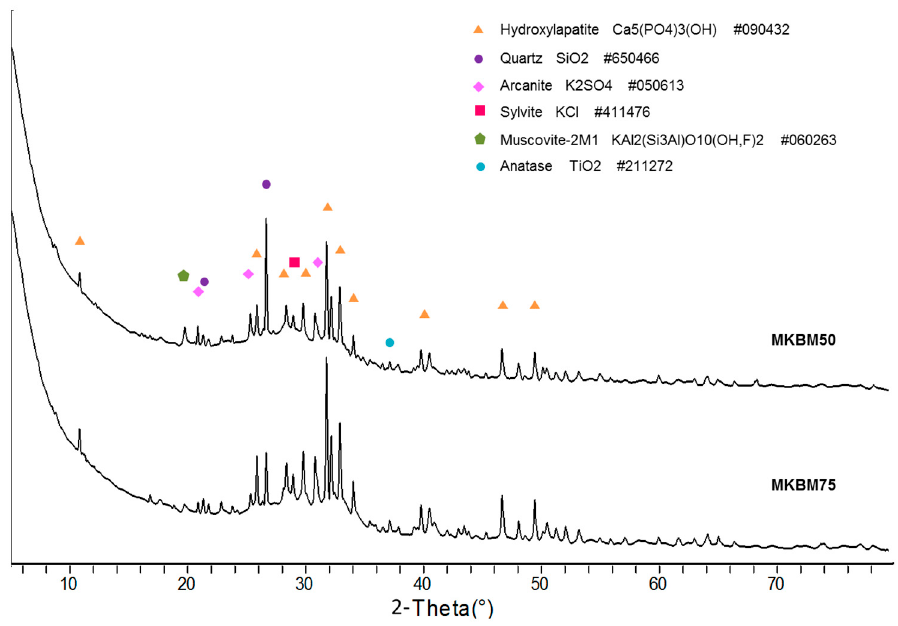
Figure 2. Phase composition of MKBM50 (top line) and MKBM75 (bottom line).